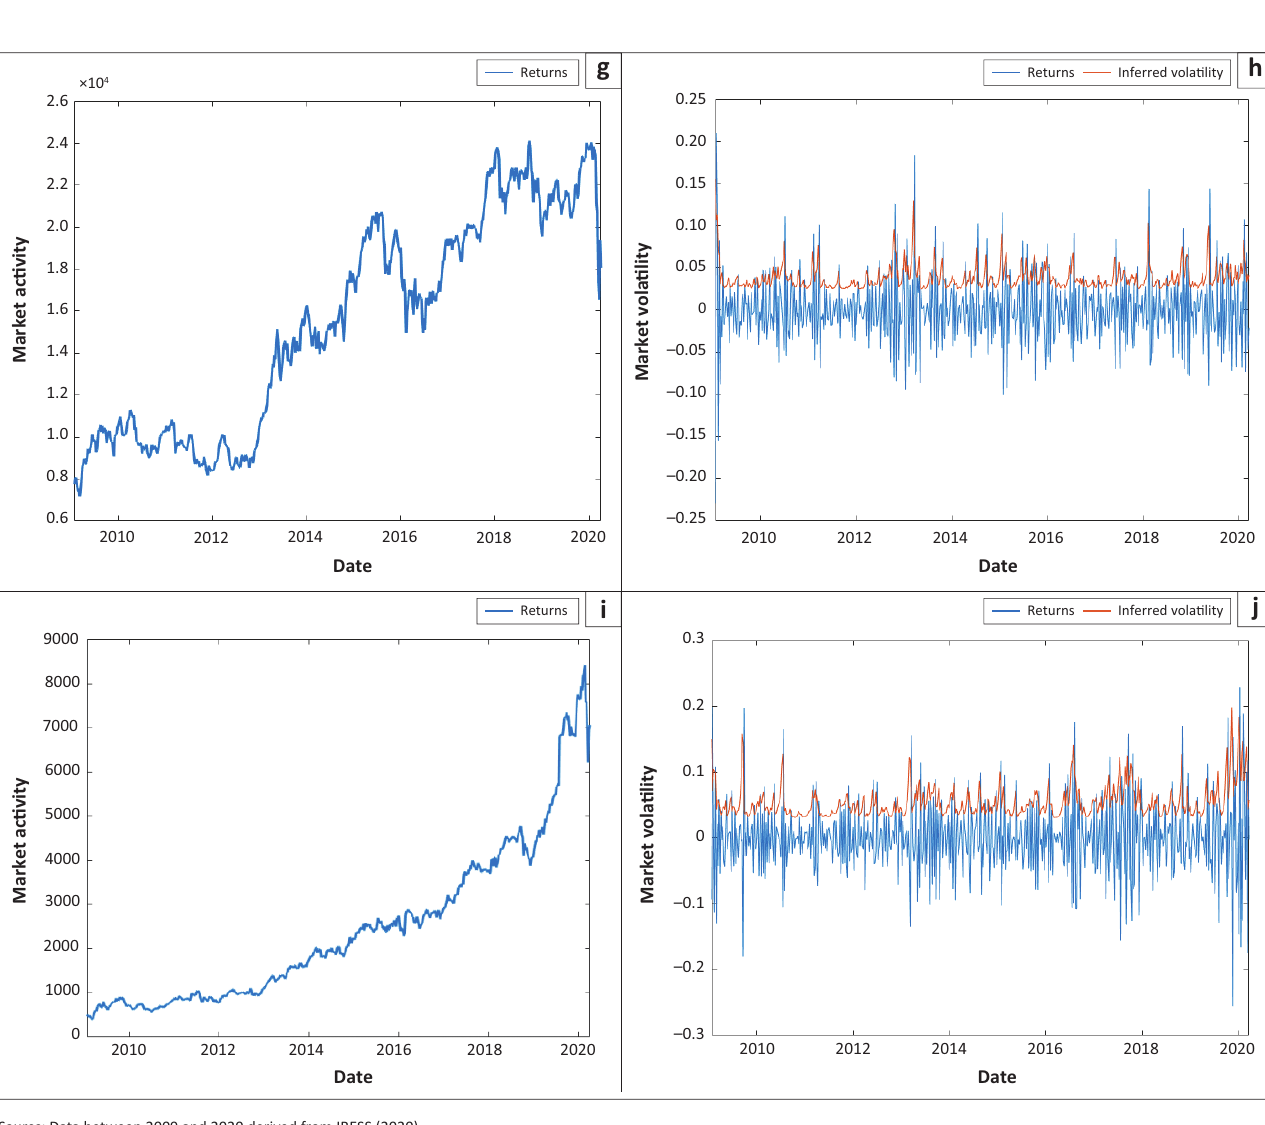
FIGURE 3 (Continues ... ): Graphical representation of the Dax, Dow Jones Industrial Average, Financial Times Stock Exchange/Johannesburg Stock Exchange All Share, Nikkei 225 and the London Stock Exchange highlighted in column 1 the Market Performance and in column 2, the ‘Returns to Investment’ and ‘Inferred Volatility’ in the market and the impact of COVID-19 on the respective stock market indices. (a) Dax, (b) Returns and inferred volatility, (c) Dow Jones, (d) Returns and inferred volatility, (e) FTSE, (f) Returns and inferred volatility, (g) Nikkei 225, (h) Returns and inferred volatility, (i) LSE, (j) Returns and inferred